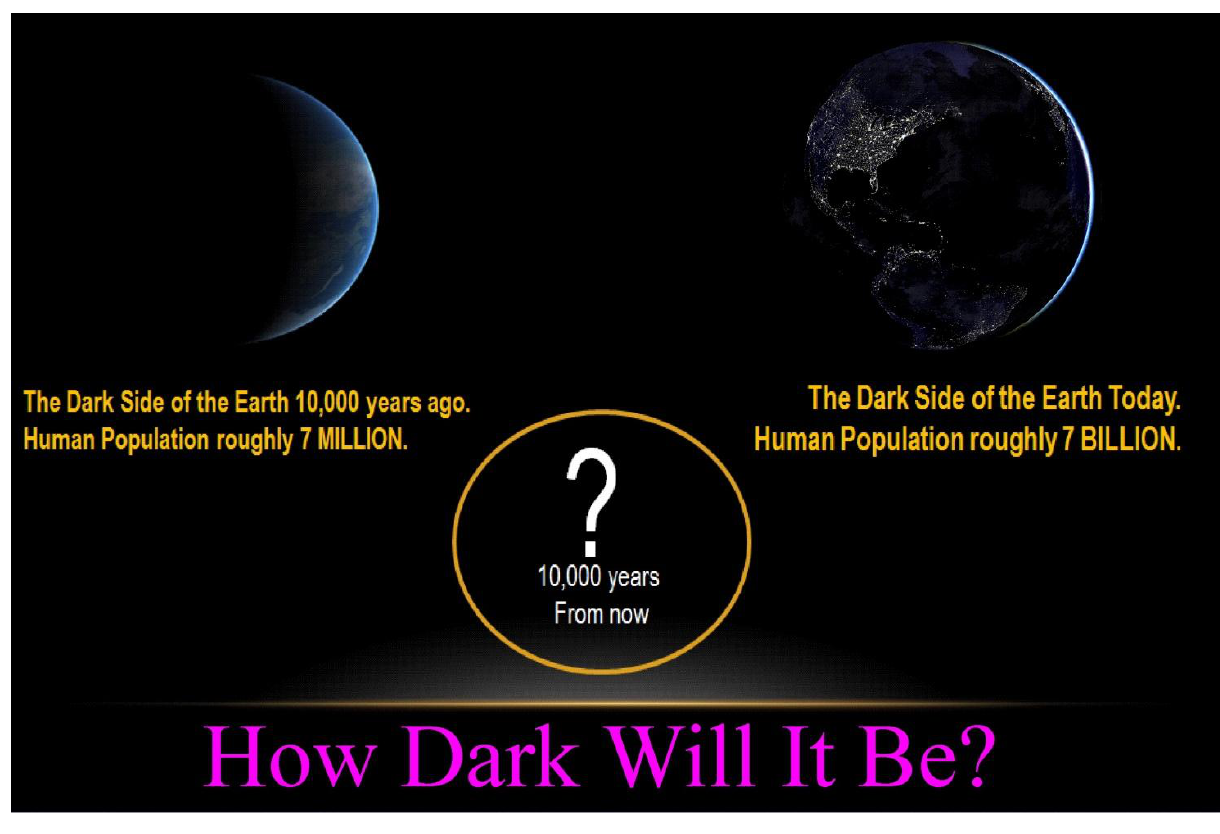
Figure 1. The ―Dark Side of the Earth‖ past, present, and